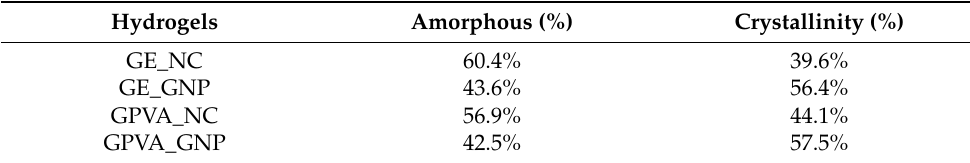
Table 1. Amorphous and crystallinity index for GPVA